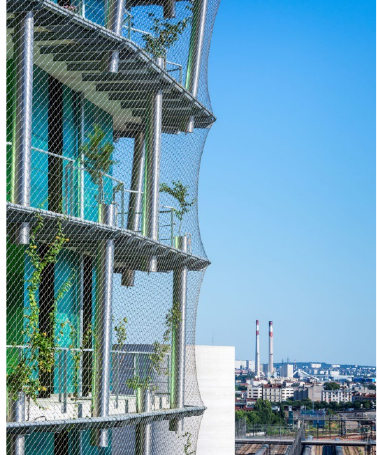
Figure 4. Tube-like planters with small trees on the Tour de la biodiversité after completion (Pierre L’Excellent 2016). Graphical